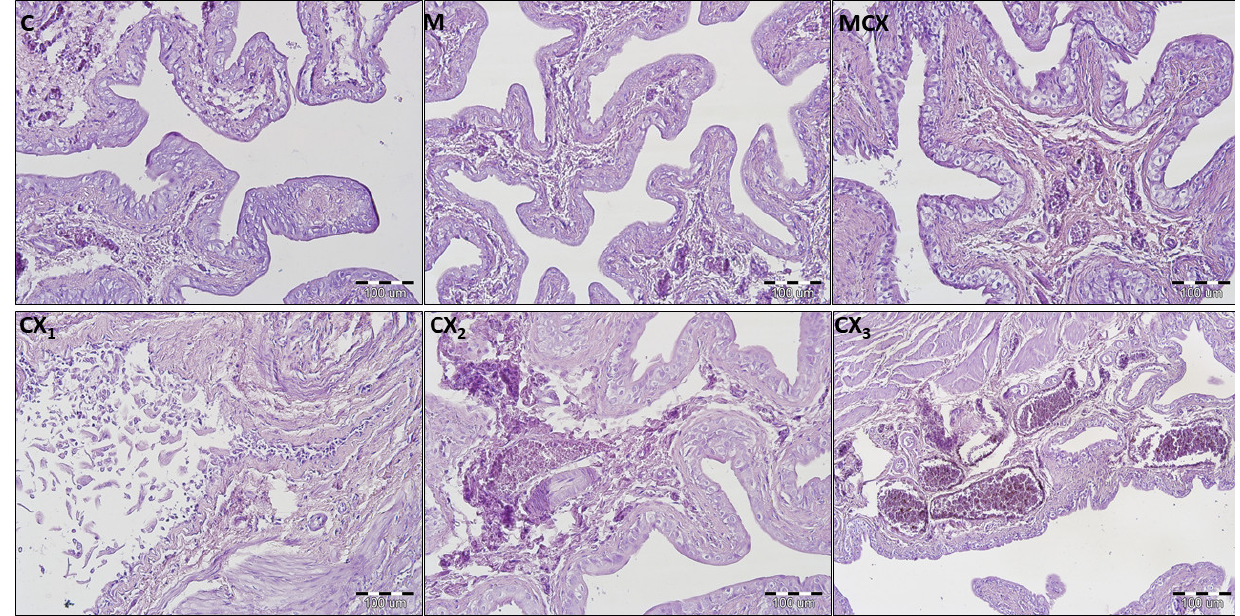
Figure 5. Histological cross-sections of urinary bladders (HE staining, magnification 200×). C—control group—no pathological changes; M—group receiving NaMSA—edema and discrete hyperemia of submucosa, there are normal 5–7 layers of transitional epithelium without atypia and some slightly dilated blood vessels; MCX—group receiving cyclophosphamide and NaMSA—edema of submucosa, there are normal 5–7 layers of transitional epithelium without atypia and some slightly dilated blood vessels; CX—group receiving cyclophosphamide—selected characteristic abnormalities; CX1—erosion of normal transitional epithelium without inflammation; CX2—edema and discrete hyperemia of submucosa, there are normal 5–7 layers of transitional epithelium without atypia and some slightly dilated blood vessels; CX3—high degree hyperemia of submucosa, there are normal 5–7 layers of transitional epithelium without atypia and some significantly dilated blood vessels.